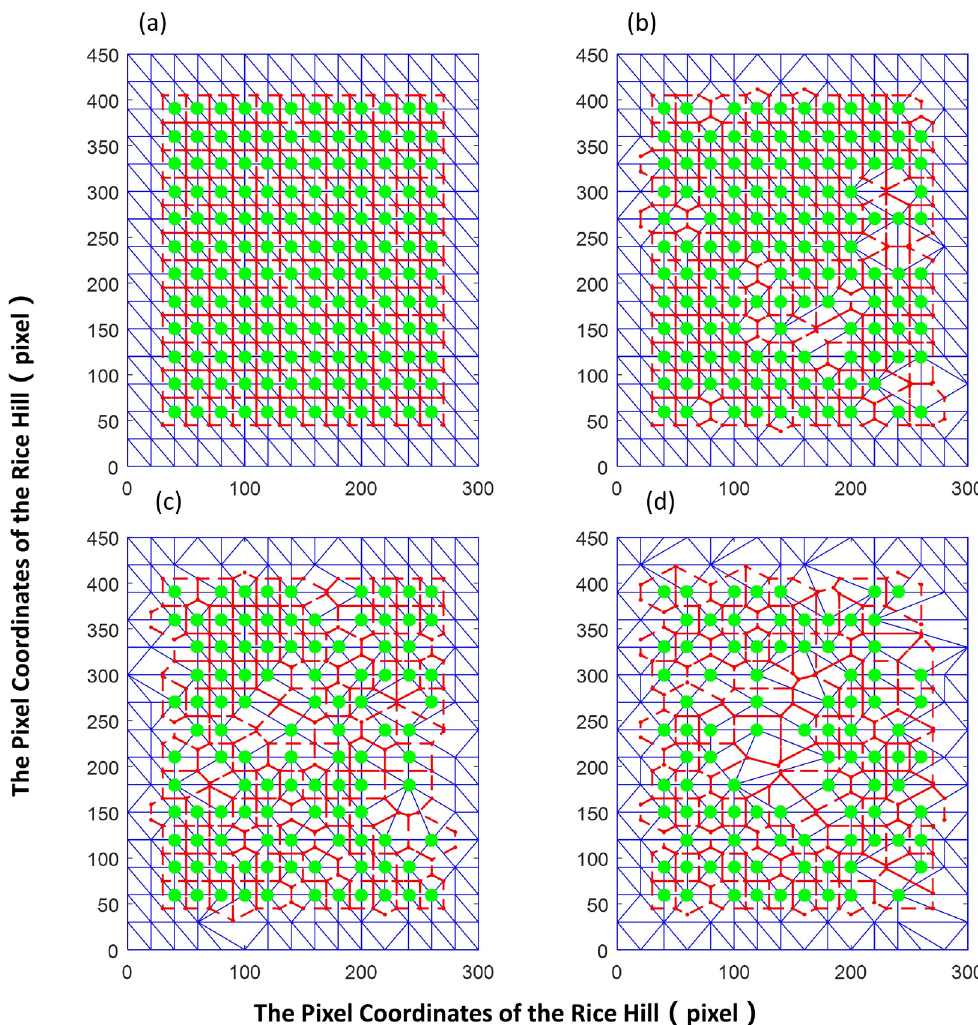
Figure 6. Distribution of the rice clusters randomly simulated at the different omission ratio and the regions occupied by the rice clusters. ( a – d ) show omission ratios of 0%, 10%, 20%, and 50%, respectively. The large dots indicate the positions of the rice cluster; the red dots indicate the outer centers of the triangles; the blue dotted line indicates the triangular segmentation result; and the red solid line indicates the boundary line of the region occupied by the rice